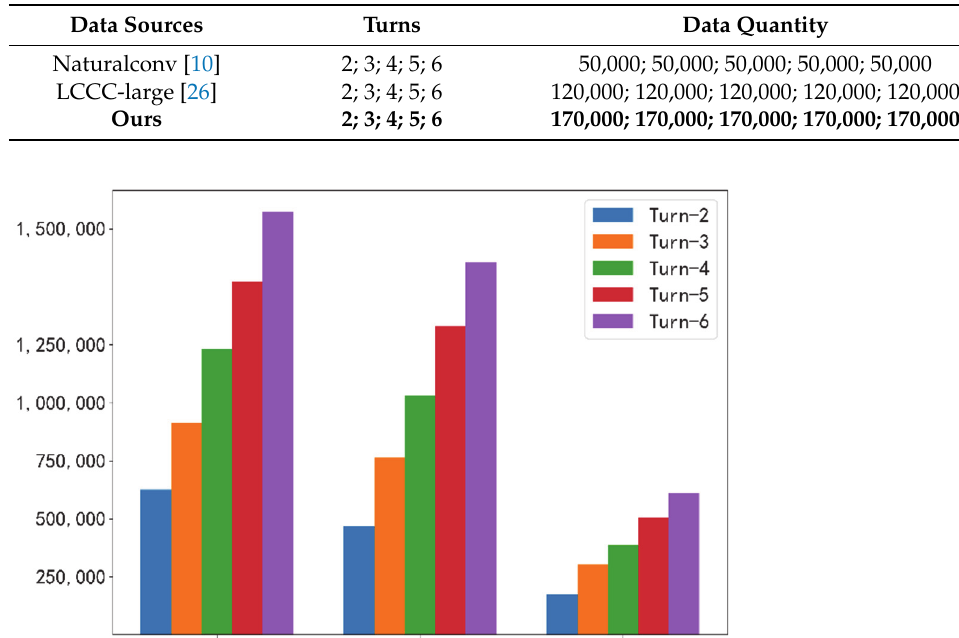
Table 2. Data sources and processing results.